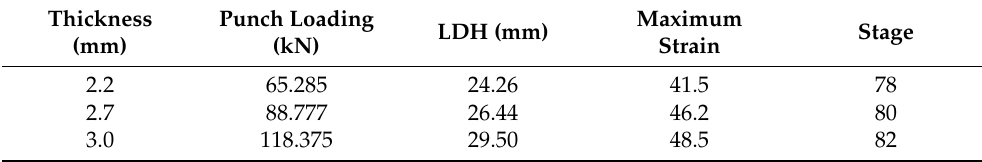
Figure 6. Strain distribution and displacement distribution after fracture of a 3 mm thick AA5754 TWB along the path (blue line) along with Mises strain and DIC overlay on the LDH specimen. Table 3. Measured formability, punch loading, maximum strain and frame in the LDH test.